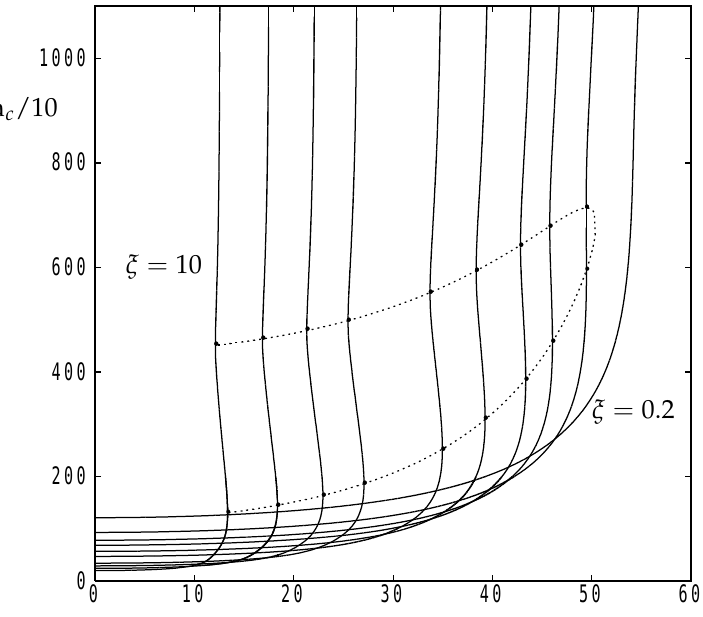
Figure 3. Showing the variation of Ra c for transverse roll disturbances at critical points on the neutral curve for ξ = 0.2 (far right), 0.3, 0.4, 0.5, 0.7, 1, 2, 3, 5 and 10 (far left). The black disks correspond either to isola points or to saddle points. The dotted lines correspond to isolae (lower curve) and saddle points (upper curve) in the surface, α = α ( Ra, k ) .